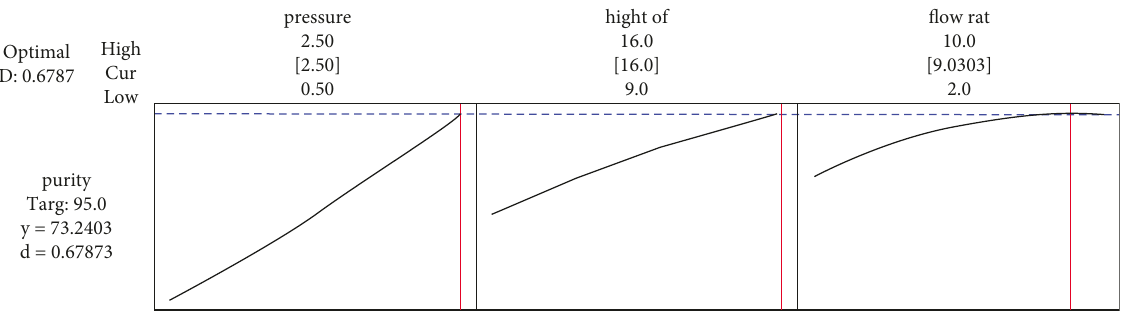
Figure 9: Optimum variables for maximum responding